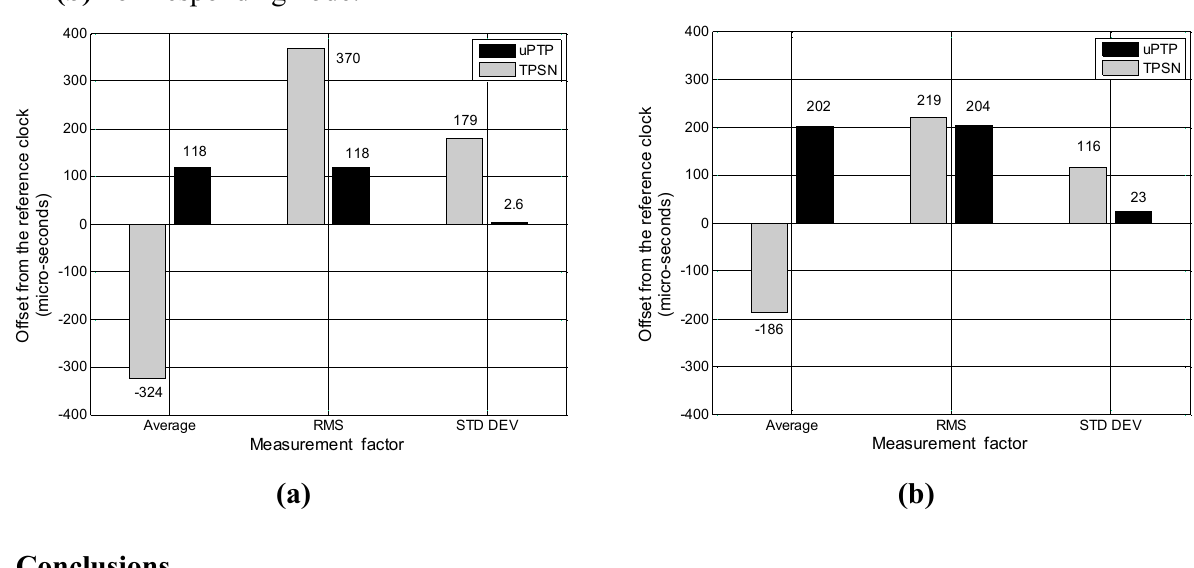
Figure 15. Synchronization results by clock drift correction. (a) responding node; (b) non-responding